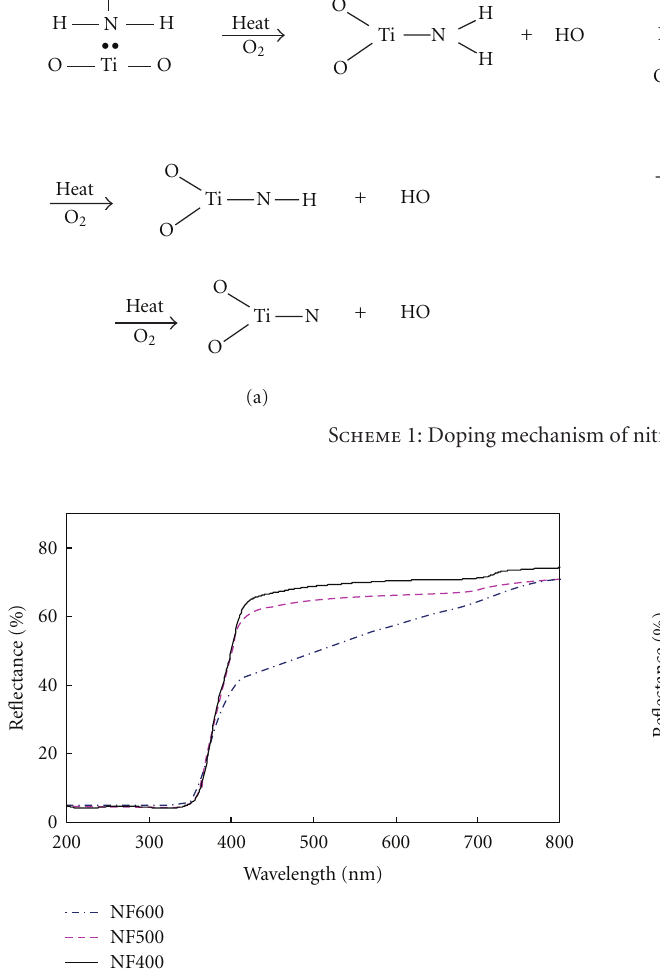
Figure 3: E ff ect of calcined temperature on the UV-Vis-DRS spectrum (NF400, NF500, or NF600 represent the NF series catalyst calcined at 400, 500, or 600 ◦ C, resp.).